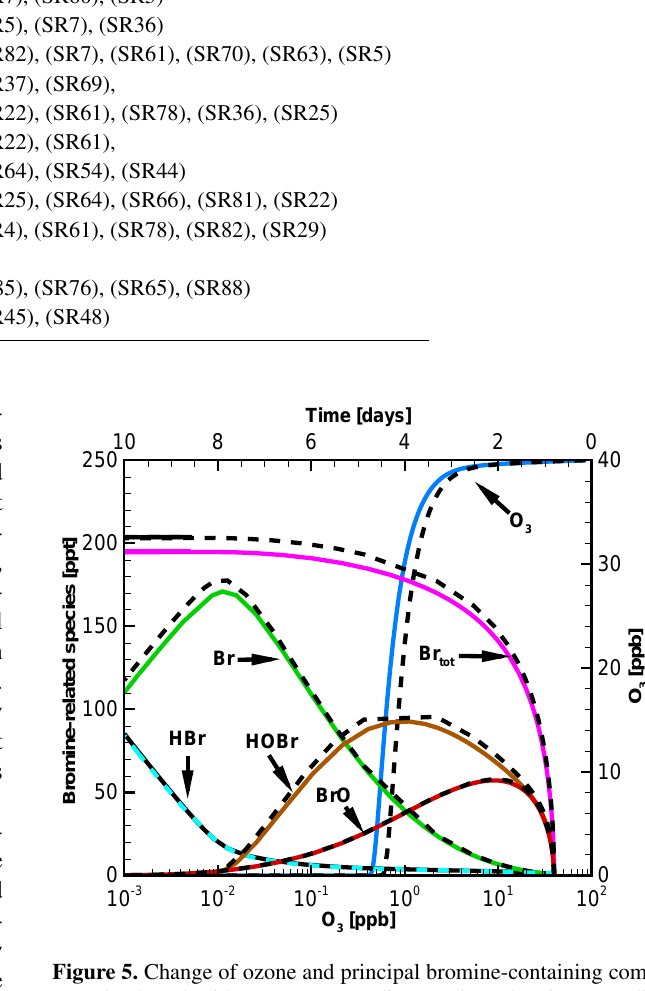
Figure 5. Change of ozone and principal bromine-containing com- pounds plotted with an ozone coordinate axis and a time coordi- nate axis. The solid curves denote the simulation results obtained by using the original reaction mechanism, and the dashed curves represent the results for the reduced reaction mechanism, which is obtained after the principal component analysis. The configuration of this figure is similar to that used in Fig.